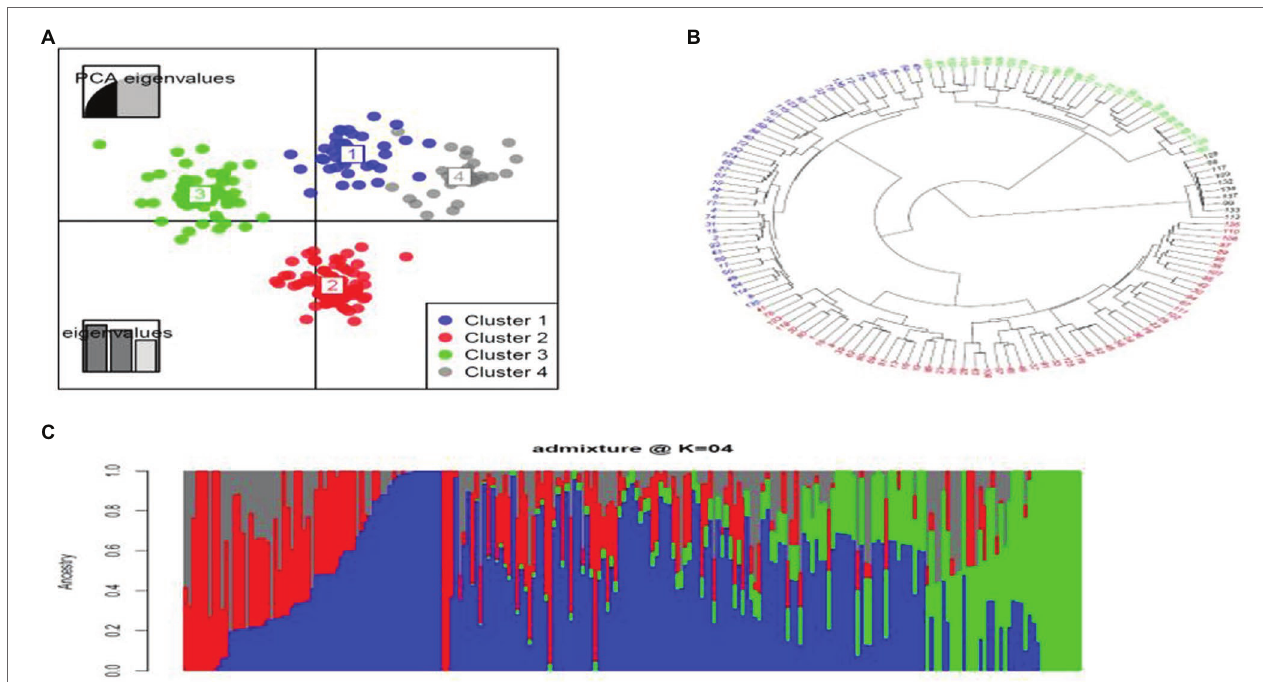
FIGURE 2 | Population structure based on analysis of 59,792 SNPs. (A) Discriminant analysis of principal components (DAPC) using 59,792 SNP markers. The axes represent the first two Linear Discriminant (LD). Each colour represents a cluster, and each dot represents an individual. Numbers represent the different subpopulations identified by DAPC analysis. (B) Neighbor-joining (NJ) phylogenetic tree displaying the genetic relationships among the 142 cassava accessions in the panel based on 59,792 SNP markers. (C) Admixture plot showing clustering of 142 cassava accessions into clusters based on the molecular data using Bayesian-based clustering analysis. Each accession is represented by a vertical bar. The coloured sections within each bar indicate membership coefficients of the accessions in the different